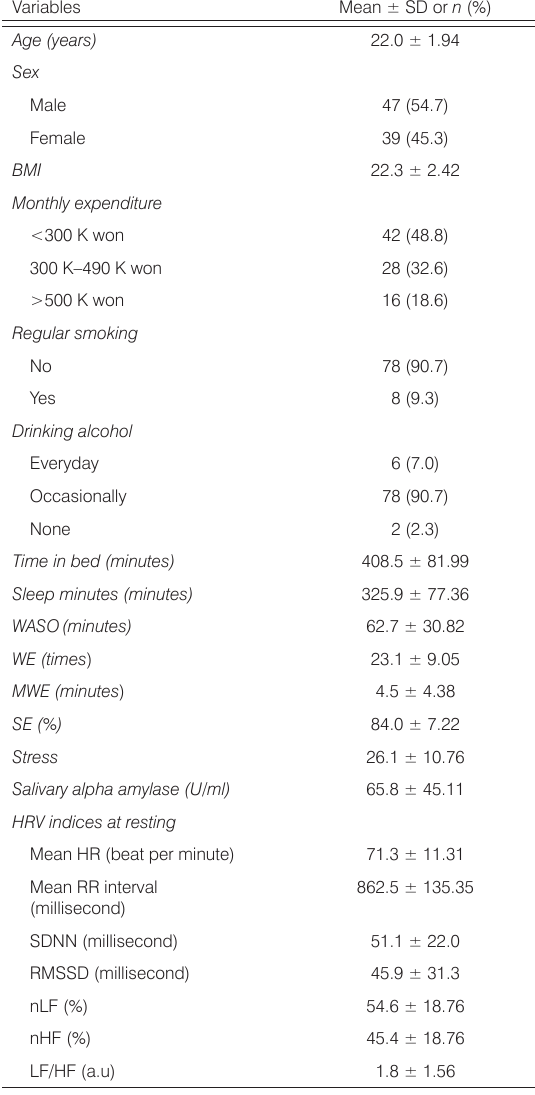
Table 3. Correlation among stress, salivary alpha amylase, HRV, and sleep behaviors ( N =